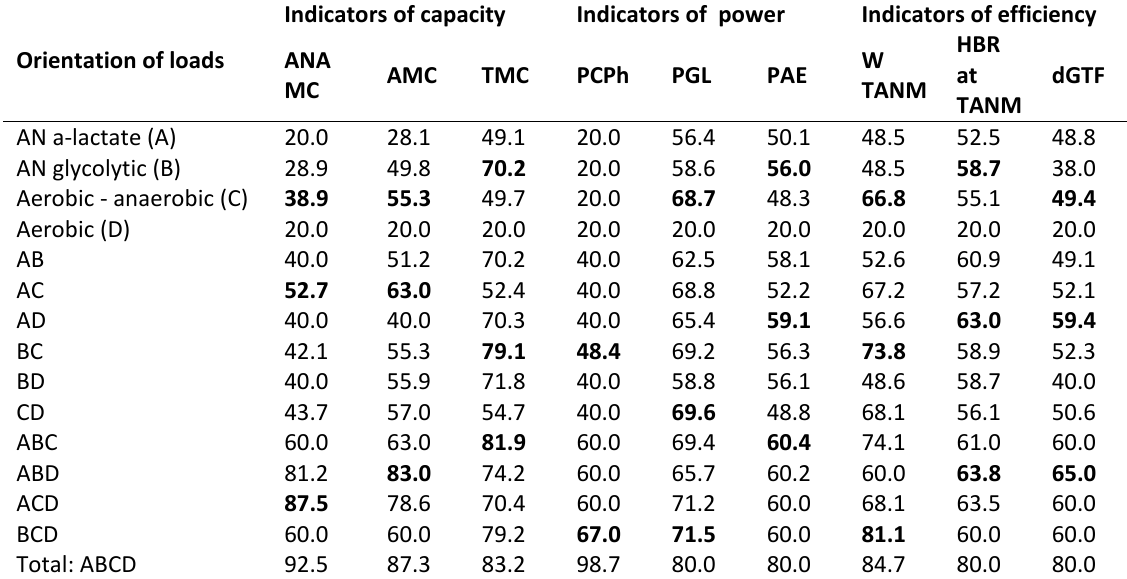
Table 3. Influence of cyclic differently physiologically oriented loads on individual dynamic of S.A. Kugayevskiy’s functional potentials in 2000–2006 (r 2 ,%) Indicators of capacity Indicators of power Indicators of Orientation of loads